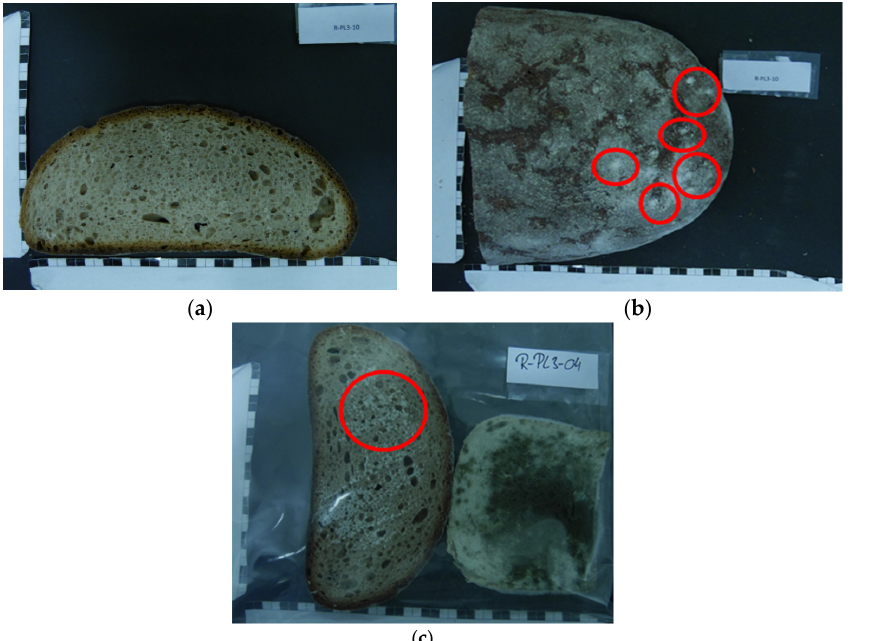
Figure A1. Exemplary presentation of the storage setup. The bread loaves were stored in four different common storage methods. ( a ) Bread loaf stored in a PE-layered microperforated paper bag (21.3 ± 0.4 °C). ( b ) Mixed-type sourdough bread stored in a bread box with 13 little ventilation holes on the back side (22.0 ± 0.5 °C). ( c ) Pan wheat bread stored in a plastic bag at room temperature (21.9 ± 0.5 °C). ( d ) Pan wheat bread and mixed-type sourdough bread stored in plastic bags at fridge temperature (8.2 ± 0.2 °C).  WDR.